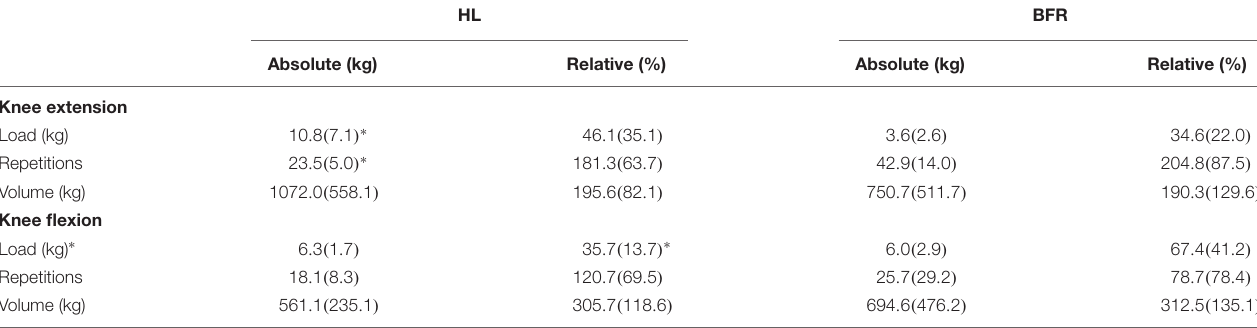
TABLE 3 | Absolute (kg) and relative (%) differences between load, repetitions and volume between weeks 1 and 12 in HL and blood flow restricted (BFR)